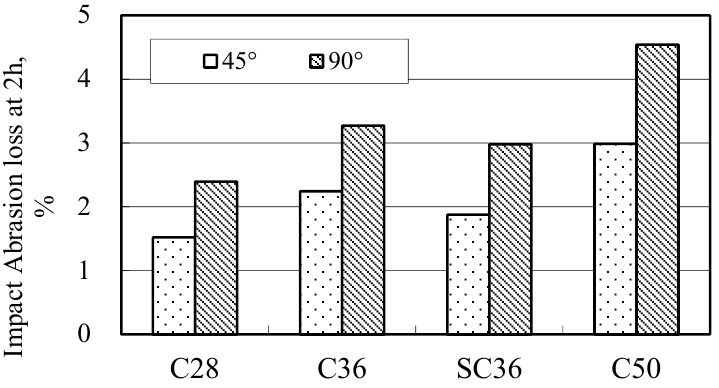
Figure 11. Total impact abrasion loss of concrete at 2 h.